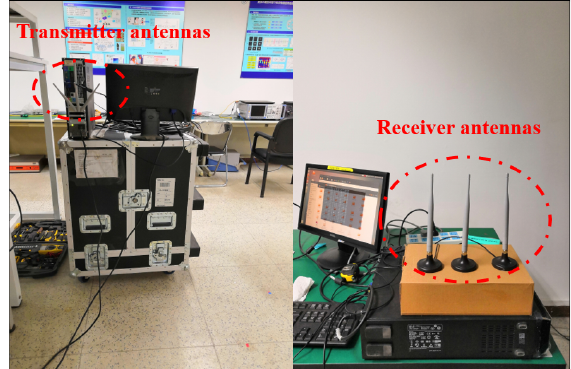
Figure 1. Data collection experimental scene and transceiver device.